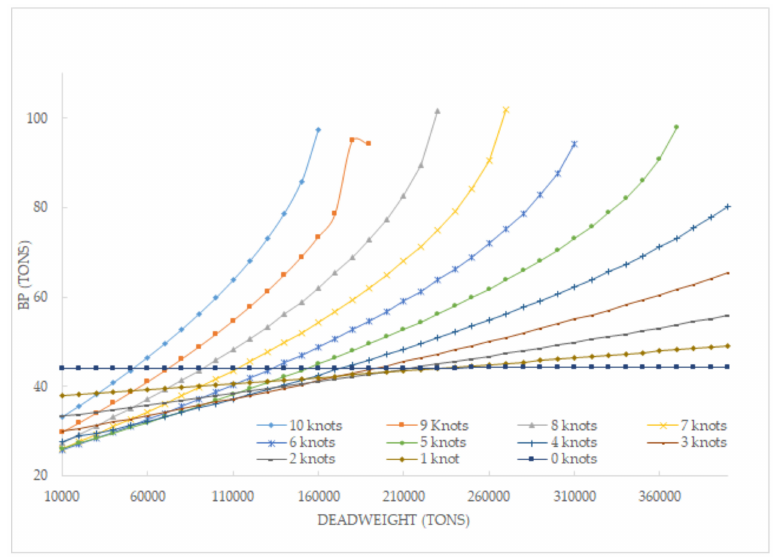
Figure 5. Tug BP needed as a function of ship’s characteristics (constant rudder angle of 15 ◦